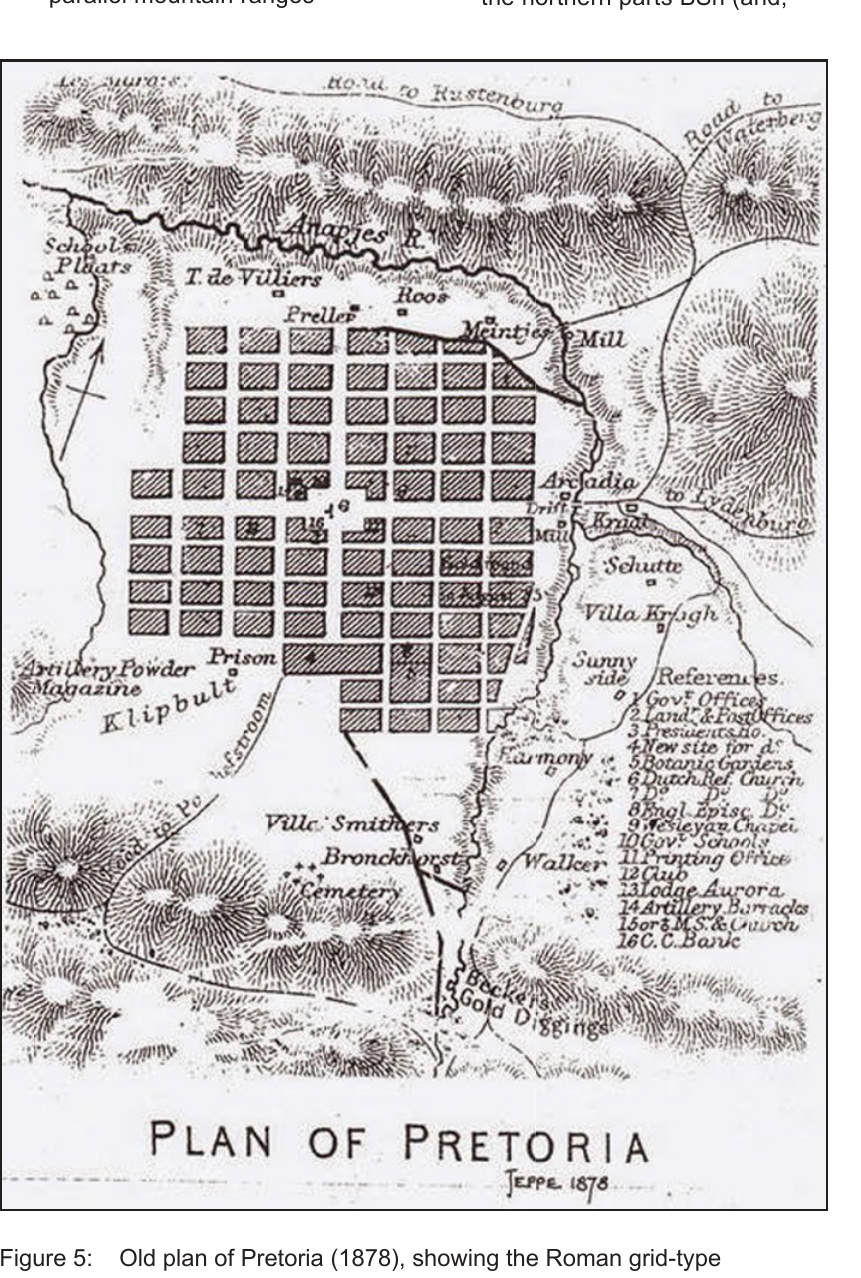
Old plan of Pretoria (1878), showing the Roman grid-type layout and natural features such as rivers, mountains and koppies that influenced future development. Note the inaccurate north indication in the